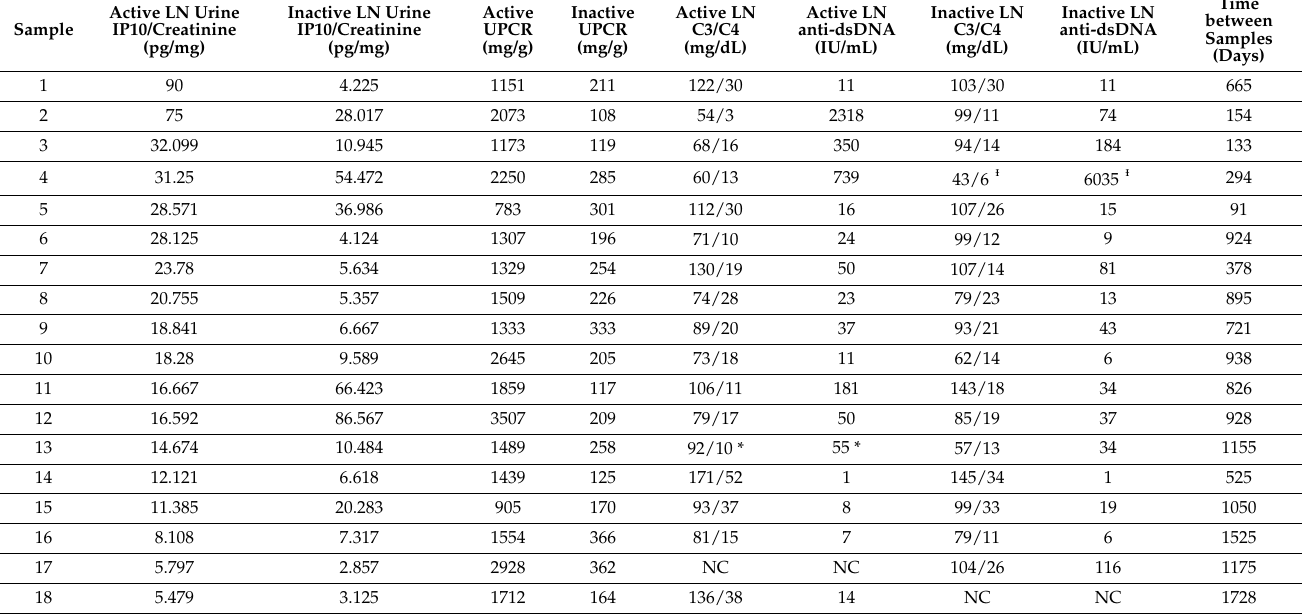
Table 2. IP-10 urine levels, proteinuria levels, and clinical characteristics from the same patients when they were in remission or in an active flare. This table corresponds with Figure 2B. Results highlighted in red indicate an abnormal result for that clinical test, with normal ranges described below the table. Not all patients had their complement and anti-dsDNA titer available, and those data are indicated as “NC” for not collected.